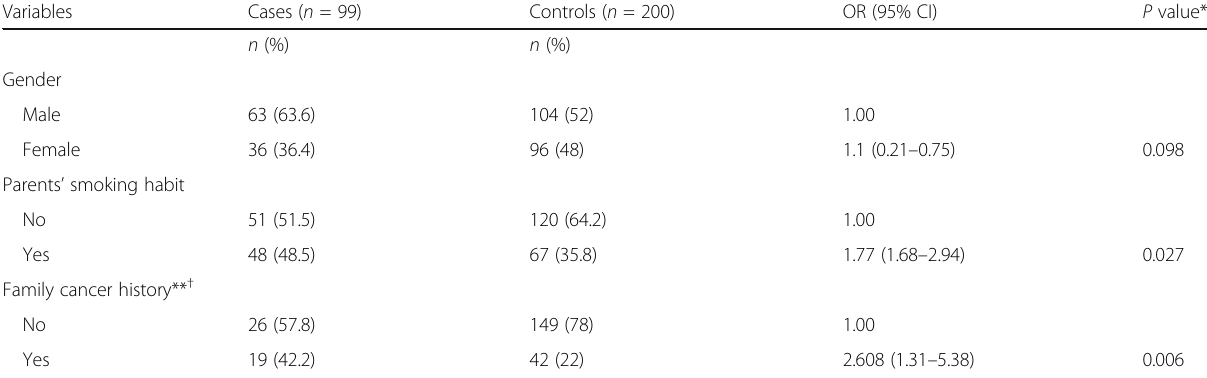
Table 1 Frequency distributions of selected variables between the acute lymphoblastic leukemia cases and controls Variables